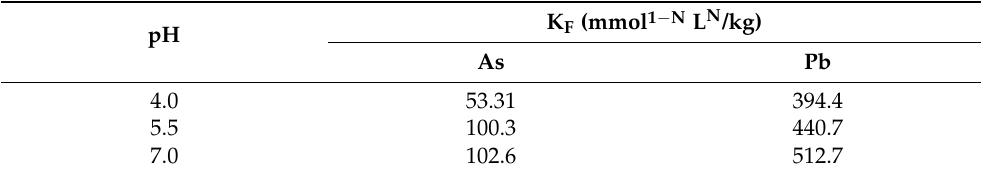
Figure 6. Effect of pH on the ( a ) As and ( b ) Pb adsorption fitted using the Freundlich model. Table 6. Comparison of the K F values in the Freundlich model.